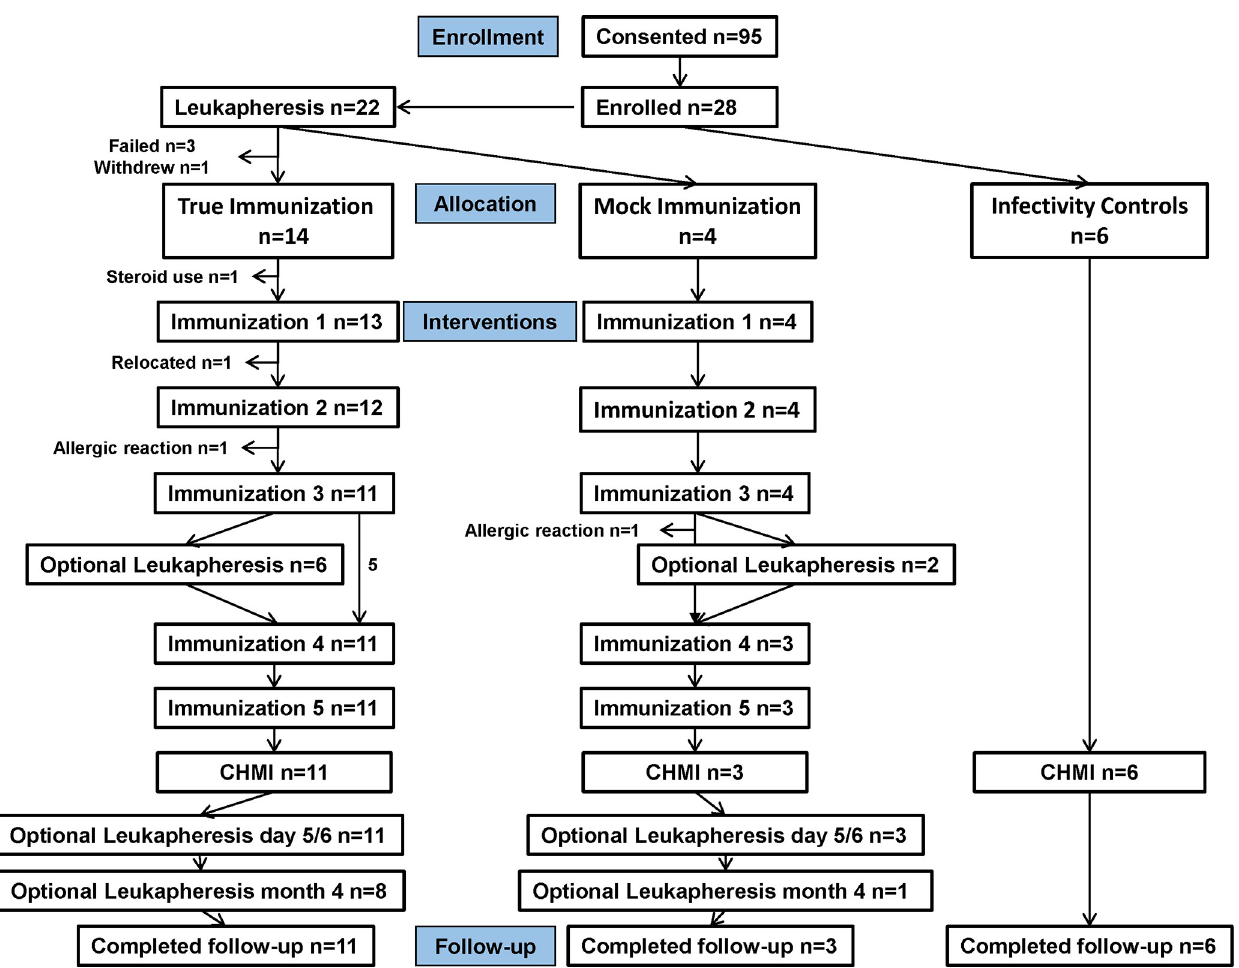
Fig 1. Cohort 1: Flow diagram of immunized and control subjects. Twenty-four subjects met all eligibility criteria and 14 were assigned to the true- immunization group, four were assigned to the mock-immunization group and the remaining six subjects were assigned as infectivity controls.